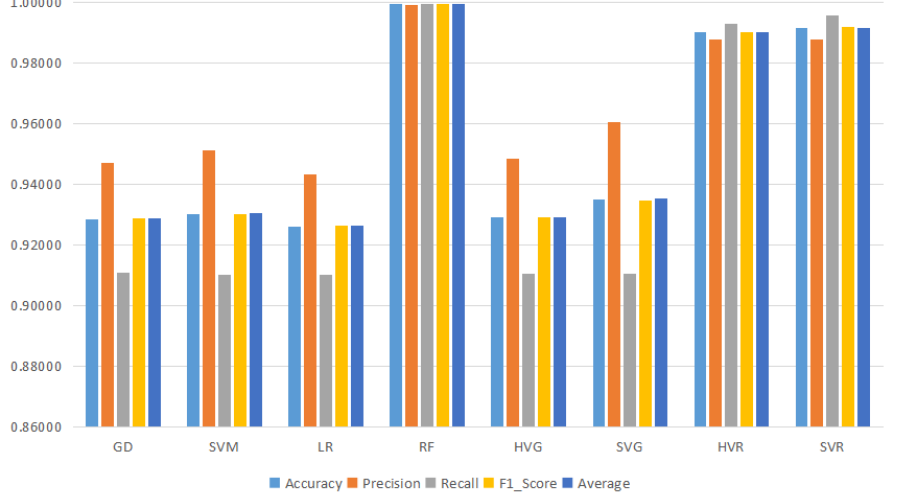
Figure 9. Performance of each model. AUC is defined as the area under the ROC curve enclosed by the coordinate axis. As shown in Figure 10, The ROC curve of each model shows that the ROC curve of RF is the closest to the standard ROC curve Figure 11, and the AUC scores of each model are shown in Table 5, where the AUC score of RF is 0.99948, which is the best performance among the models, corresponding to the histogram Figure 12. Model selection algorithm AUC scores for each model.